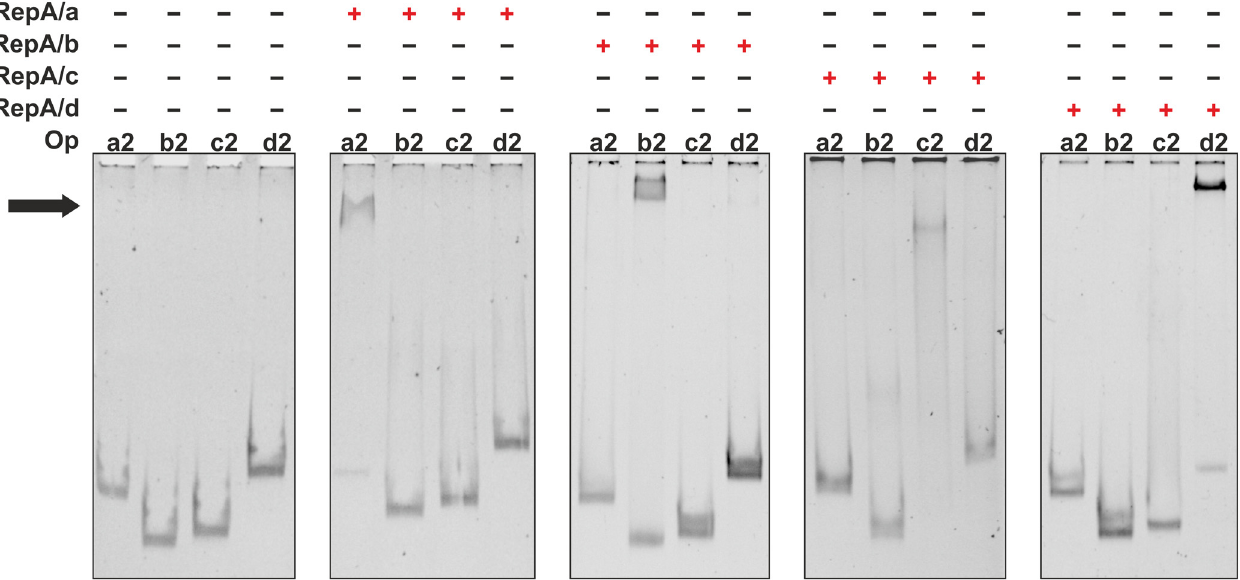
Fig 4. EMSA based analysis of His 6 -RepA proteins binding specificity to operator (Op) sequences originating from parental and non-parental plasmids. DNA fragments (15 ng) (identical as those marked in Fig 2) designated a2, b2, c2 and d2 comprised mapped operators. Red '+' means presence of respective His 6 -RepA protein (100 pmol) in the binding reaction. Black arrow indicates position of the retarded DNA bands.